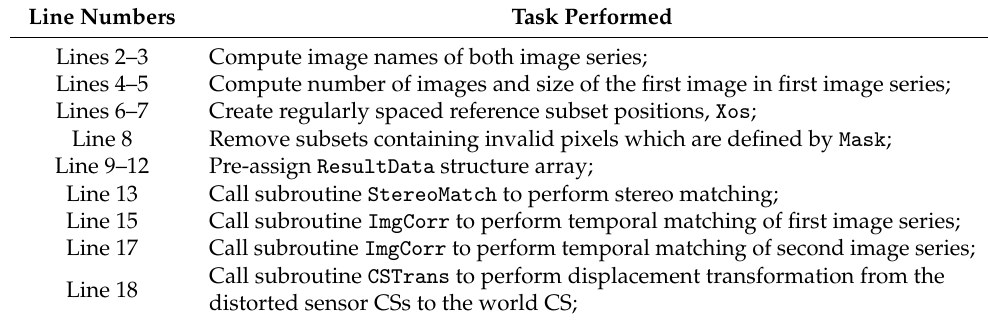
Table 5. ADIC3D algorithm